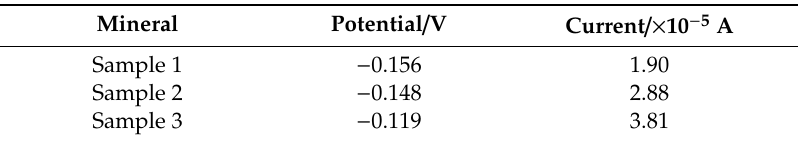
Figure 11. Tafel curves for the three samples in a solution at pH = 8 with xanthate concentration of 1.8 × 10 − 4 mol / L at scan rate of 5 mV / s. Table 6. Electrochemical corrosion parameters for the three samples in a solution at pH = 8 with xanthate concentration of 1.8 × 10 − 4 mol /